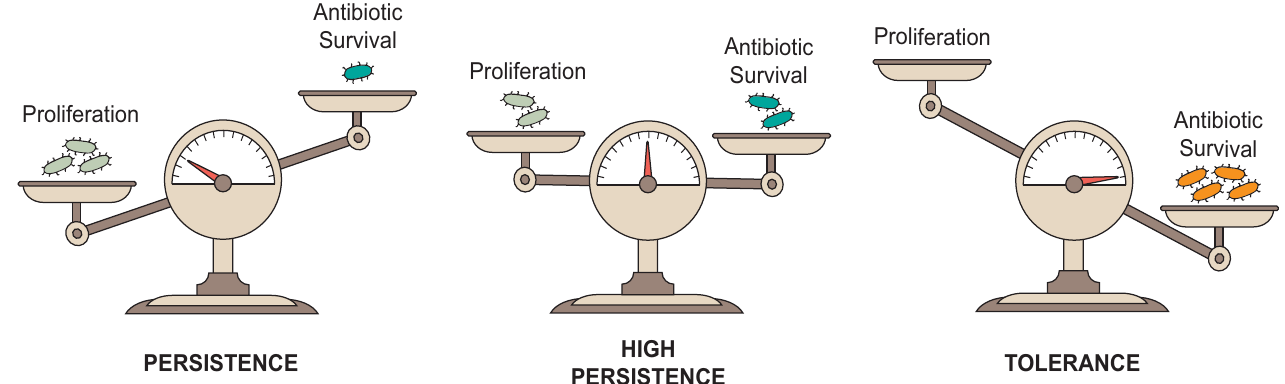
Fig 6. Trade-off between proliferation and survival in antibiotic tolerance and persistence. In the case of antibiotic persistence, the majority of cells grow in the population (light blue), allowing bacteria to efficiently colonize their environment. Persisters (turquoise) represent a small reservoir of recalcitrant cells that outlive their growing counterpart under antibiotic treatment. The frequency of persisters in the population can be increased in some conditions ( e . g . during macrophage infection) or in specific genetic backgrounds ( shpAB1 ), at the detriment of the pool of growing bacteria. On the other hand, antibiotic tolerance (orange) strongly reduces the proliferation of the entire population which, in turn, limits the efficacy of the antibiotic treatment on all cells.